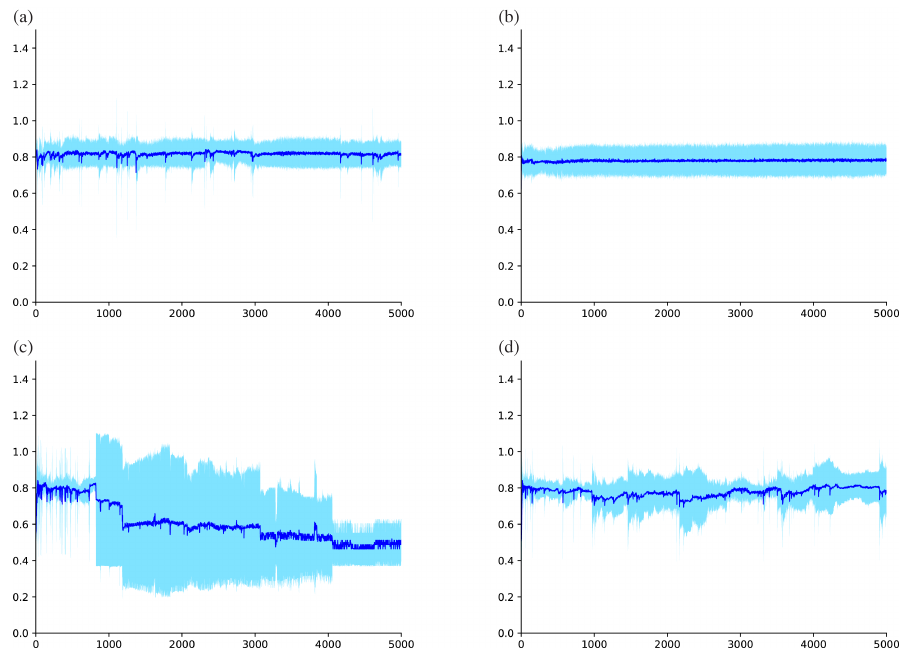
Figure 3. Training curve showing validation accuracy for each model during a long period between epochs 1 and 5000: ( a ) multilayer perceptron (MLP) (baseline), ( b ) MLP with element-wise input scaling (EIS) (baseline), ( c ) Diet Networks ( γ = 0.1), and ( d ) Diet Networks with EIS ( γ = 0.1). Note that the classification accuracy of Diet Networks gradually dropped to around 0.5 as training proceeded. Vertical axis and horizontal axis indicate accuracy mean ± standard deviation and number of epochs,